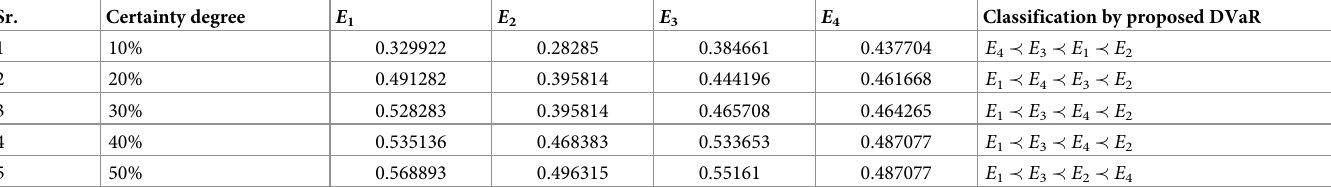
Table 1. DVaR results under PIVHF environment.